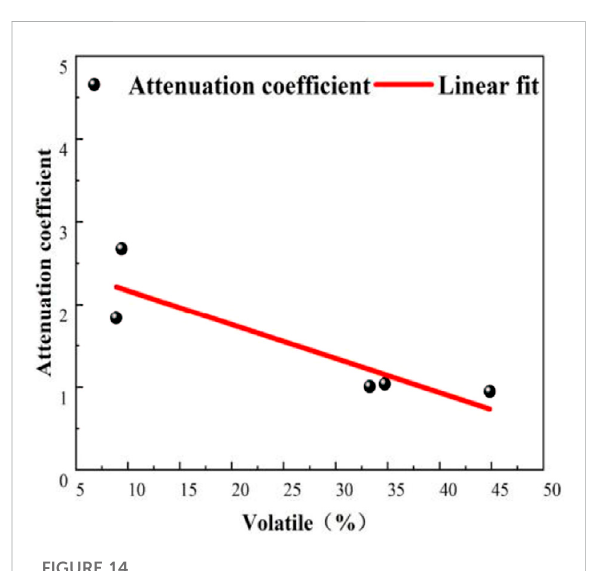
FIGURE 14 Fitting curveofattenuationcoef fi cient values ofcoalsamples in igneous intrusion